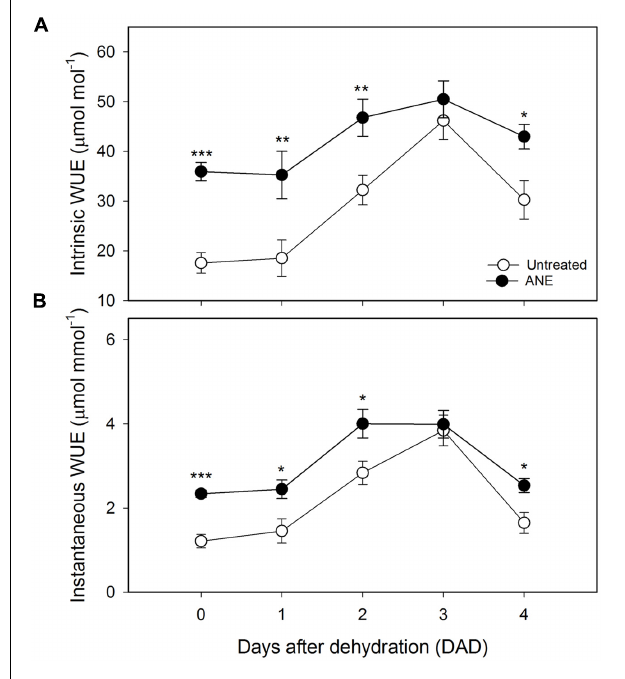
FIGURE 5 | Water use efficiency (WUE) variation during the dehydration period. Time 0 is the dehydration stress starting time and it corresponds exactly with the last day of Ascophyllum nodosum extract (ANE) treatment. Measurement of intrinsic (A) and instantaneous (B) WUE for untreated and ANE-treated plants. Each dot shows the mean ± SE of nine biological replicates. Untreated (white dot) and ANE-treated (black dot) samples were analyzed by one-way ANOVA ( P < 0.05), ∗ P ≤ 0.05; ∗∗ P ≤ 0.01; ∗∗∗ P ≤